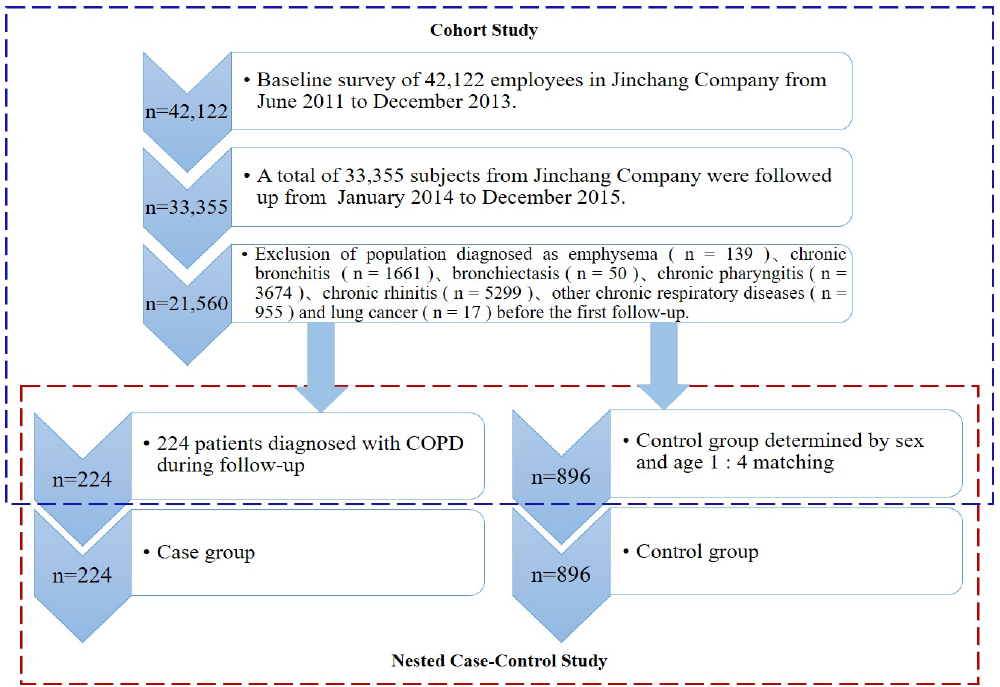
Figure 1. Flow chart of inclusion of the research population.